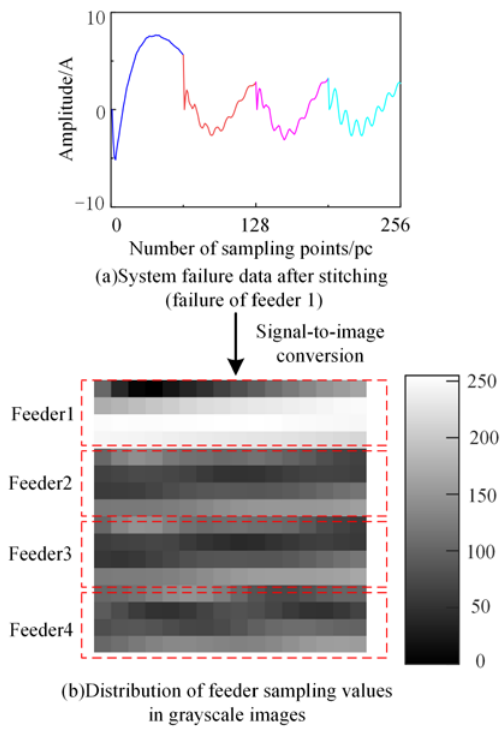
Figure 7. System failure grayscale image feature analysis diagram. The darker the color of the pixel in the graph, the smaller the corresponding TZSC sampling value. The lighter the color of the pixel in the graph, the larger the corresponding TZSC sampling